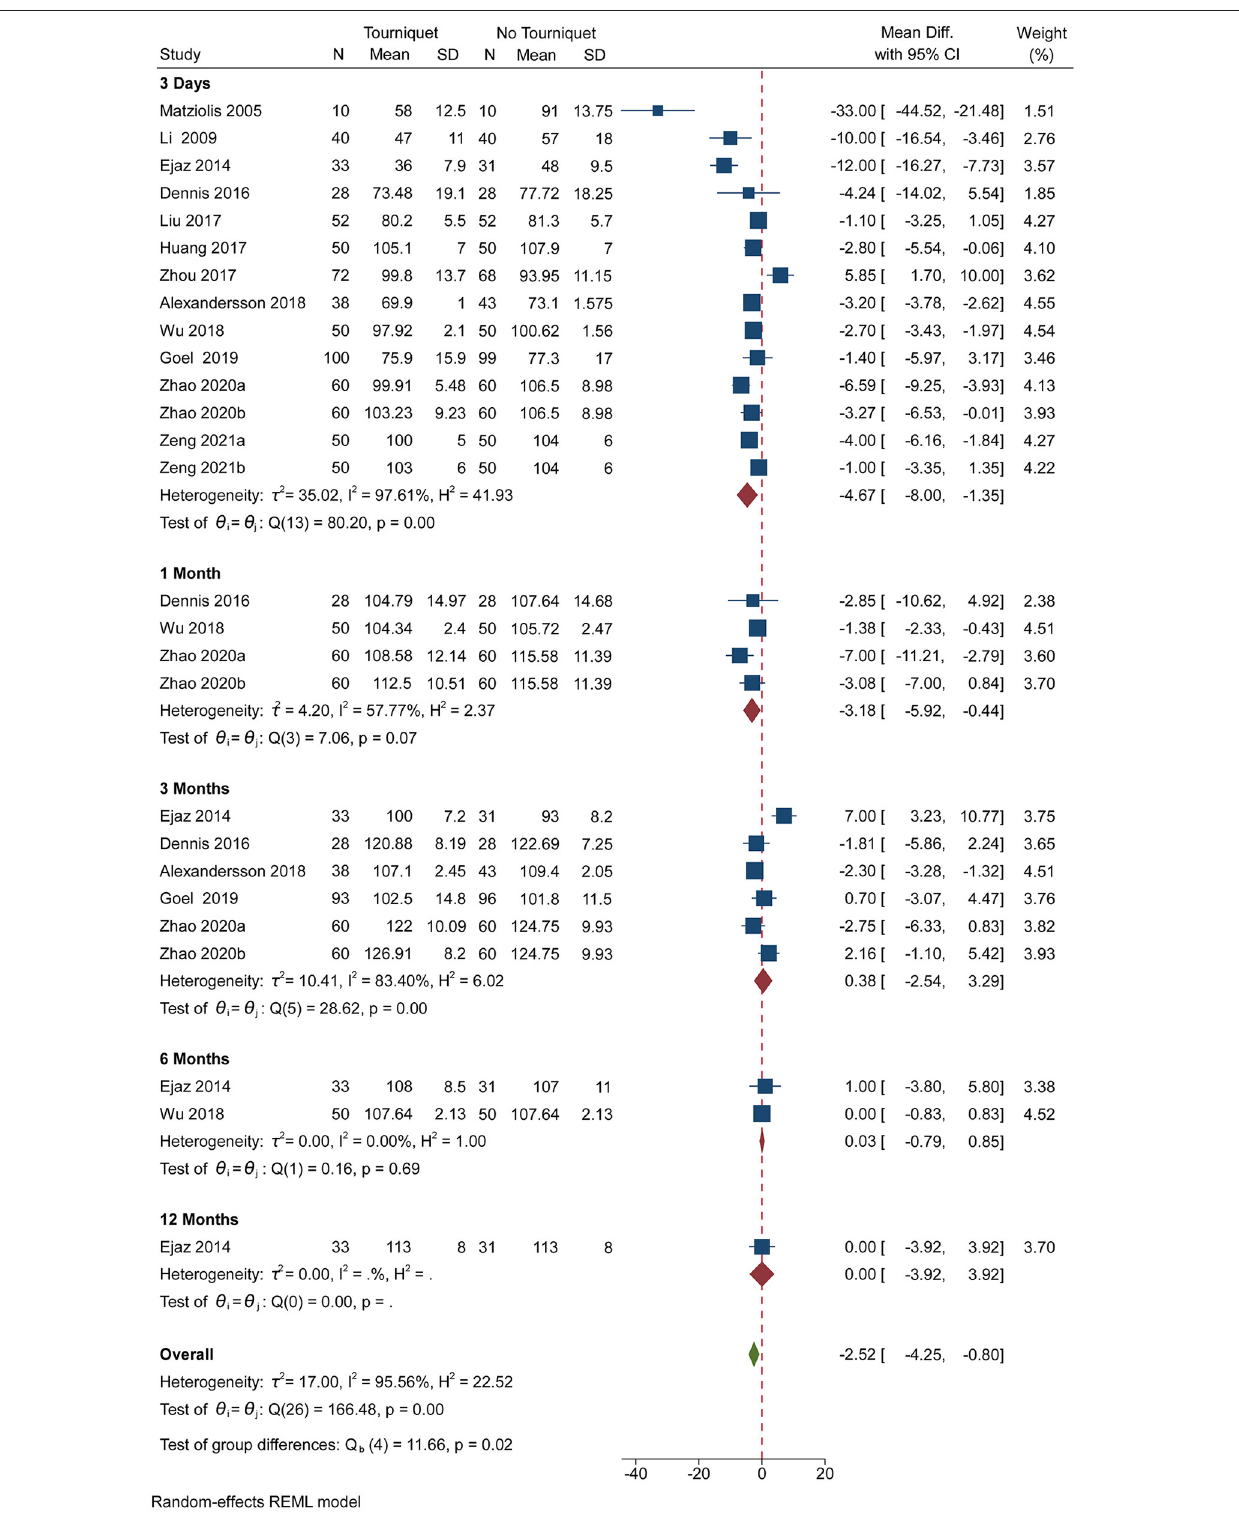
Frontiers in Public Health |